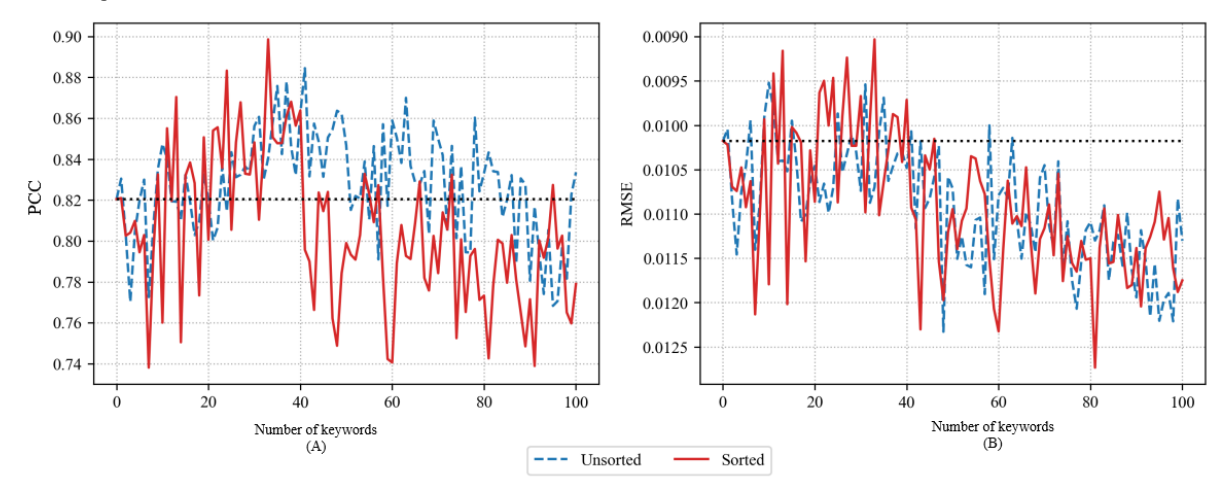
Figure 5. Pearson correlation coefficient (PCC) (A) and root-mean-square error (RMSE) (B) of long short-term memory models using FastText continuous